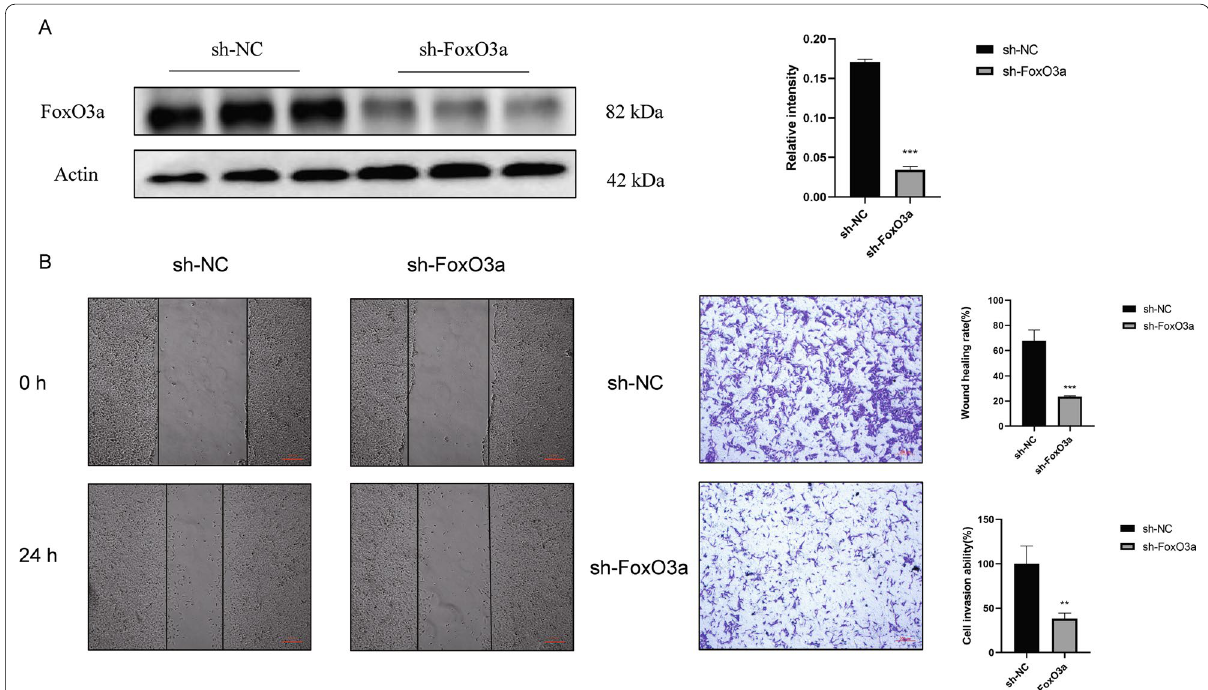
Fig. 1 Detection of transfection efficiency of lentivirus targeting FoxO3a in HTR8/SVneo cells and the abilities of migration and invasion of HTR8/ SVneo cells after FoxO3a depletion. A After 48 h transfection of lentivirus, the expression of FoxO3a in HTR8/SVneo cells was analyzed by Western Blot. B Wound‑healing assay and Matrigel transwell assay illustrated migration and invasion abilities after FoxO3a depletion. Results are shown as mean SEM, n 3, ** P < 0.01 and *** P < 0.001 ± =